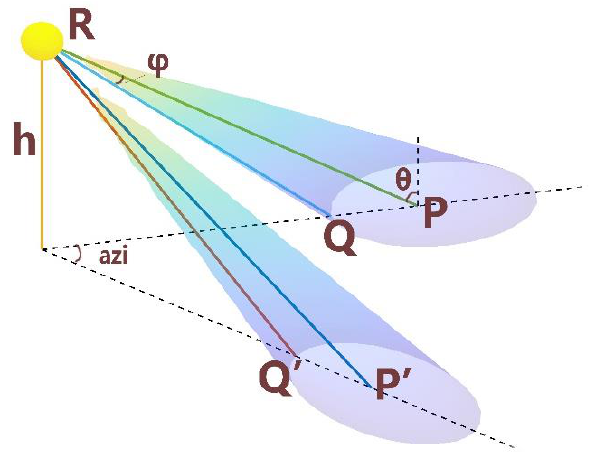
Figure 7. Schematic diagram of FOV of a drone-borne radiometer.